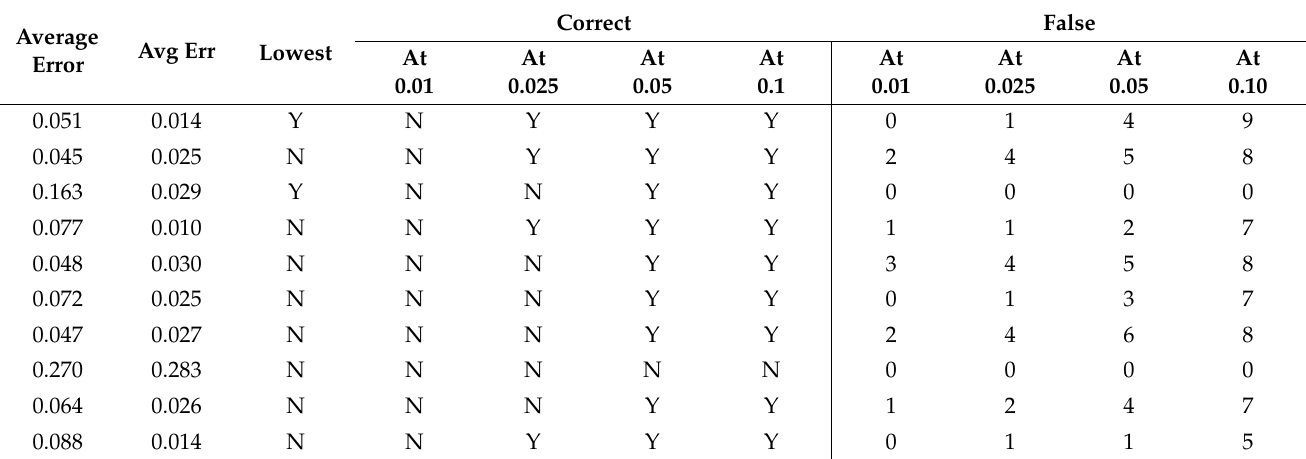
Table A153. Set 2, trials 41–50 summary data (single 0.5 PR value).